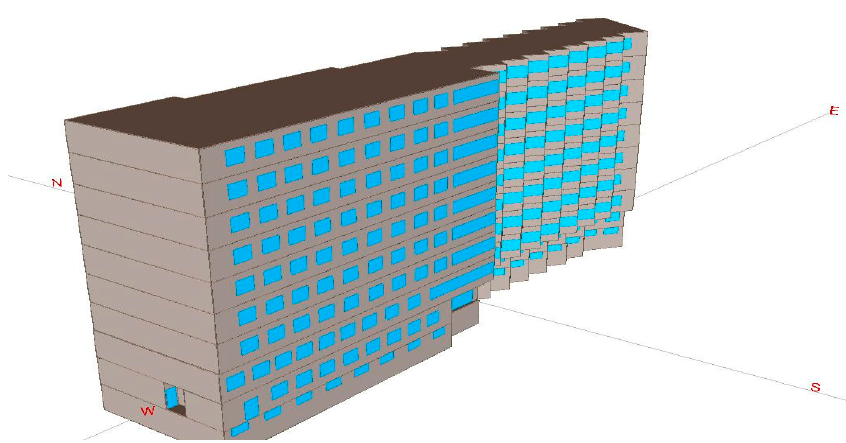
Figure 2. Building geometric model for energy modeling. Table 1. Typical input parameters of building for building simulation.